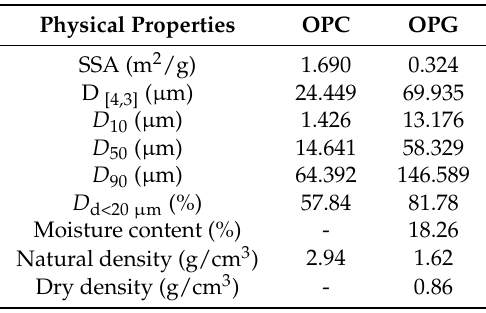
Table 2. Physical properties of OPC and